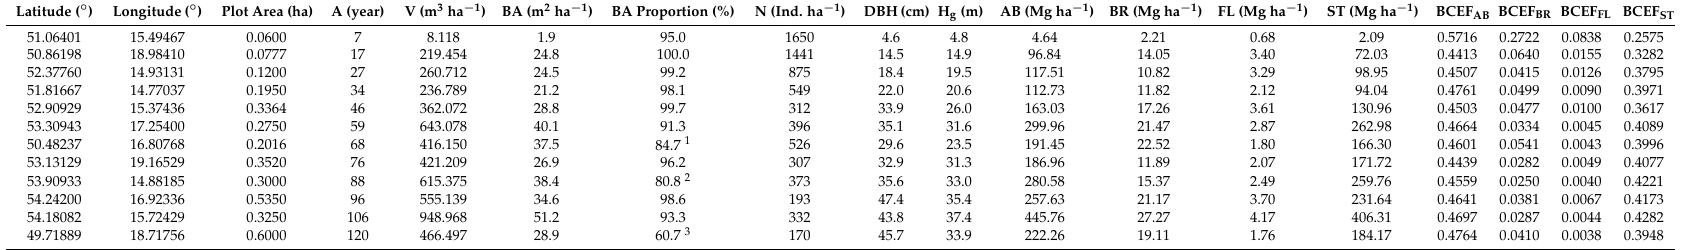
Table 1. Overview of the study plots and forest stand